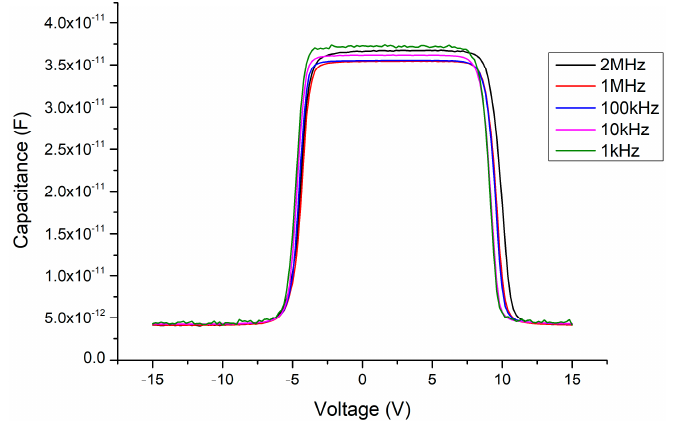
Figure 11. C–V measurement results of the MSM varactor.